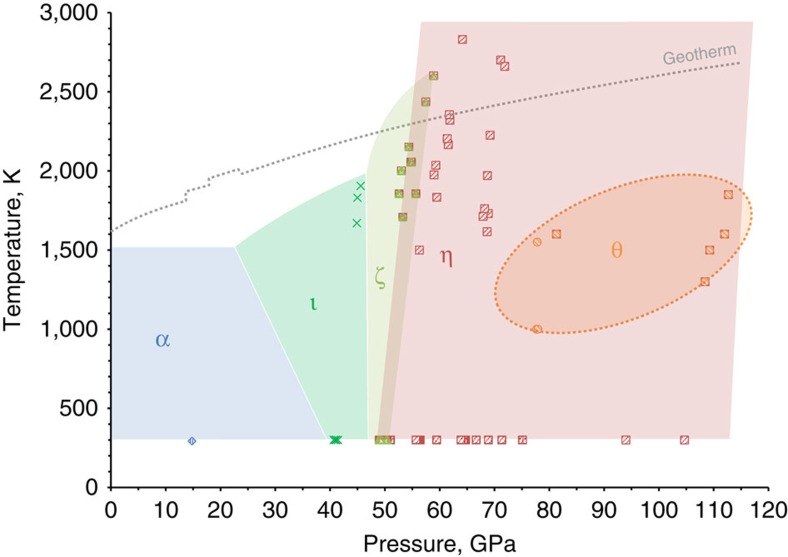
Transformational phase diagram of Fe2O3.(a) ⋄- hematite (α-Fe2O3), Δ- distorted perovskite (ζ-Fe2O3), ○-Aba2 (θ-Fe2O3, probably metastable), □-Cmcm post-perovskite (η-Fe2O3) and × -Rh2O3-II type phase (). The boundary between hematite α-Fe2O3 and  is defined according to ref. 10. The geotherm is defined according to refs 39, 40.